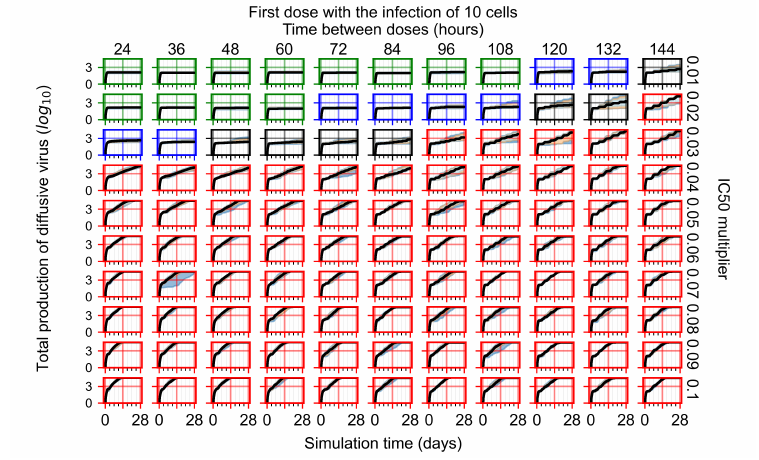
Figure A44. Total diffusive virus produced (AUC), Y axis in log scale, and exponent values as tick marks.